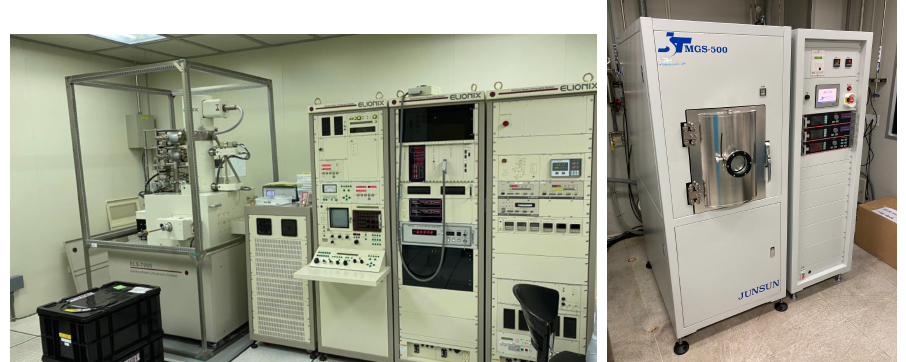
Figure 18. Electron beam lithography machine located in ( Left ) Academic Sinica laboratories (EBL, ELS-7000 ELIONIX); and ( Right ) Junsun Tech MGS-500 sputtering machine installed at the NEMS center of